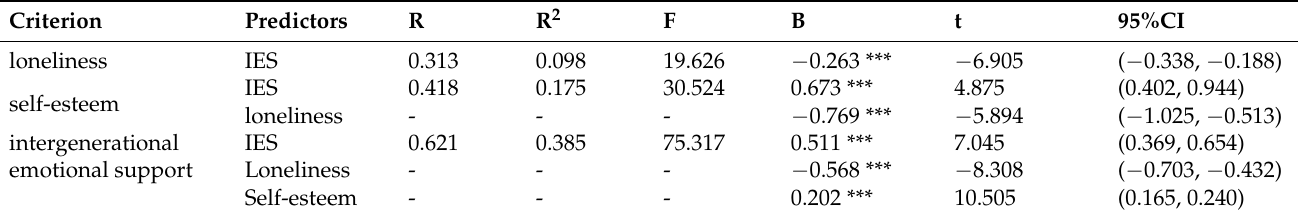
Table 3. Regression coefficients in the serial mediation analysis ( n = 728).